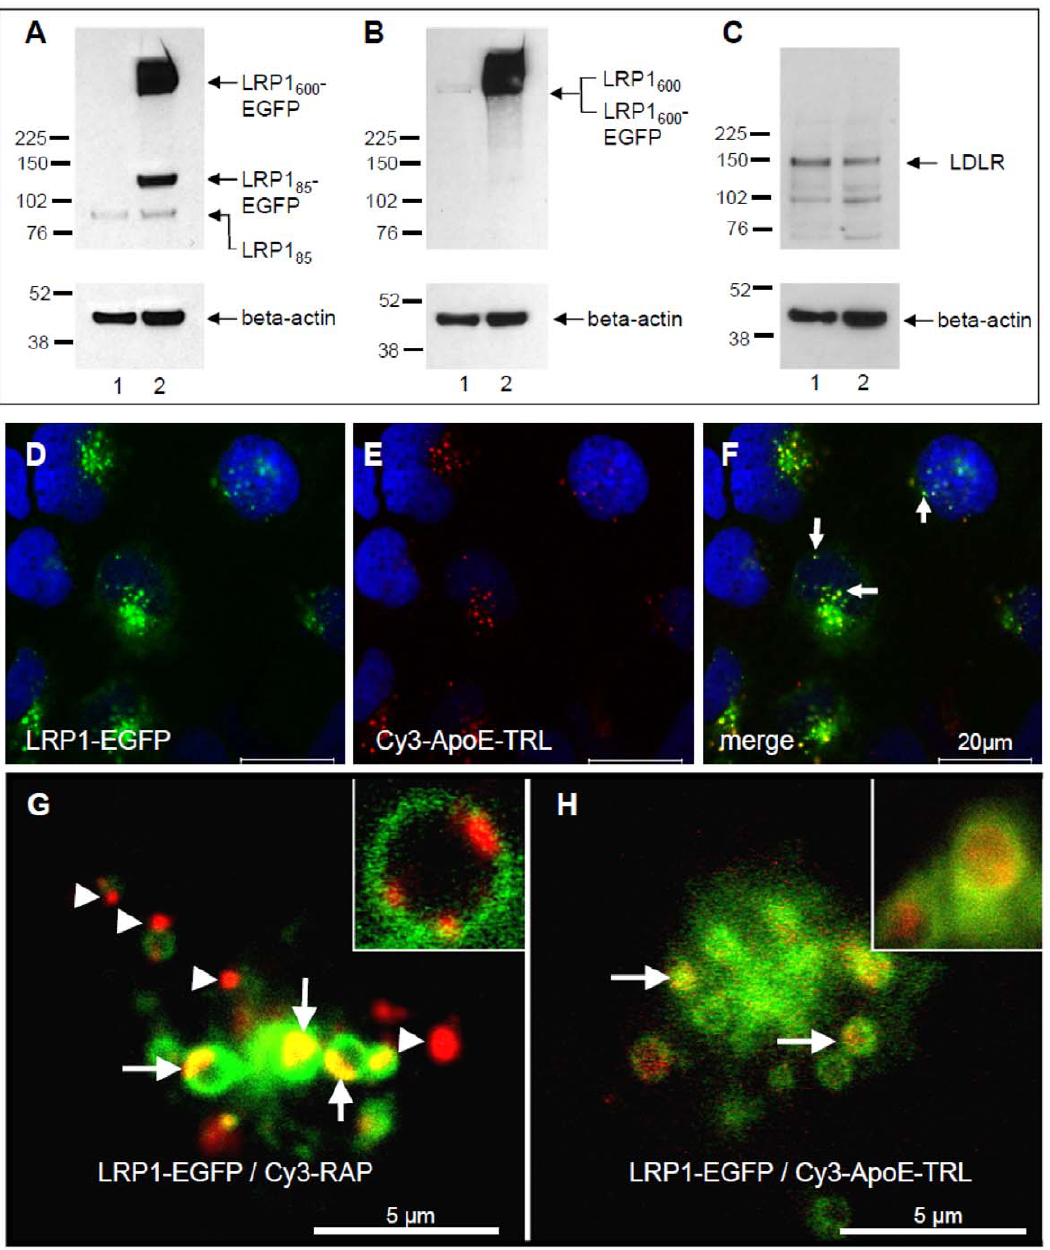
Figure 5. LRP1-dependent sorting of apoE and RAP. Cell lysates from EGFP (lane 1 in A, B and C) or LRP1-EGFP (lane 2 in A, B and C) transfected cells were subjected to SDS-PAGE, and Western blotting was performed with antibodies against the 85 kDa subunit of LRP1 (A), the 515 kDa subunit of LRP1 (B) and the LDLR (C). The endogenous LRP1 precursor protein is cleaved by furin into 515 kDa and 85 kDa fragments (shown in lane 1 of A and B). The recombinant LRP-EGFP can be detected at approximately 600 kDa (lane 2 in A and B) and for the cleaved 85 kDa fragment fused to EGFP at 115 kDa (LRP1 85 -EGFP; lane 2 in A). The overexpression of LRP1-EGFP expression slightly reduced the expression of LDLR (C). Western blotting using an antibody against beta actin verified equal protein loading. LRP1-EGFP transfected HEK293 cells were incubated with Cy3-apoE-TRL for 30 min. Confocal microscopy revealed strong colocalization of LRP1-EGFP and Cy3-apoE in endosomal compartments (D–E; see arrows in panel F; nuclei are stained with DAPI). High-magnification confocal live-cell microscopy of LRP1-EGFP expressing cells incubated with Cy3-RAP (G) or Cy3- apoE-TRL (H) revealed that RAP is still attached to the inner leaflet of the vesicular membrane and does not diffuse freely within the lumen (G, arrows and inlet). Additionally, RAP was detected in small, dense vesicles not containing LRP1 (G, arrowheads). In contrast, apoE was only present within LRP1-EGFP endosomes and evenly distributed inside the lumen (H, arrows). Bar is 5 (G–H) and 20 m m (D–F), respectively.